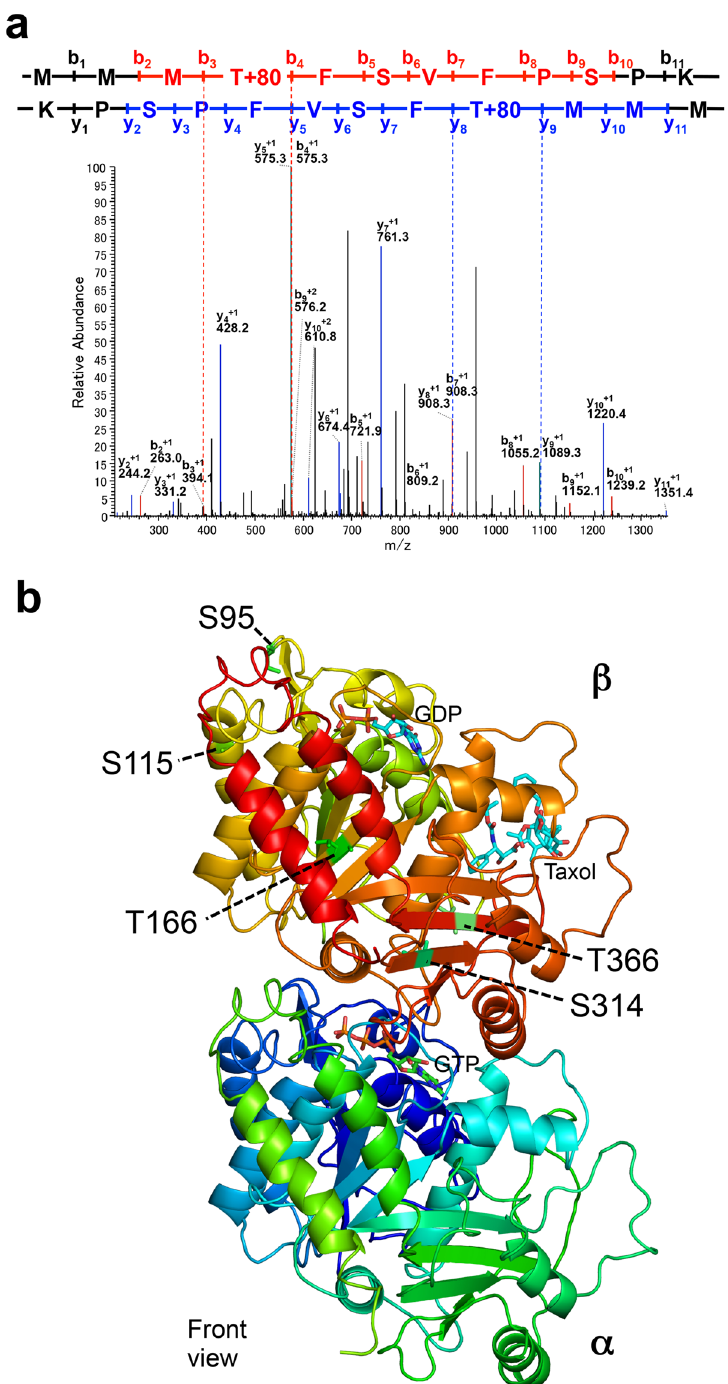
Figure 6. Phosphorylation sites of β -tubulin. ( a ) MS/MS spectrum of a phosphopeptide (163-MMMpTFSVFPSPK-174) from NEK6-treated TUB4. ( b ) NEK6 phosphorylation sites of β -tubulin. Five phosphorylation sites are shown on the structure of α / β -tubulin heterodimer. The tubulin structure is shown as a ribbon diagram (front view from the outside of the